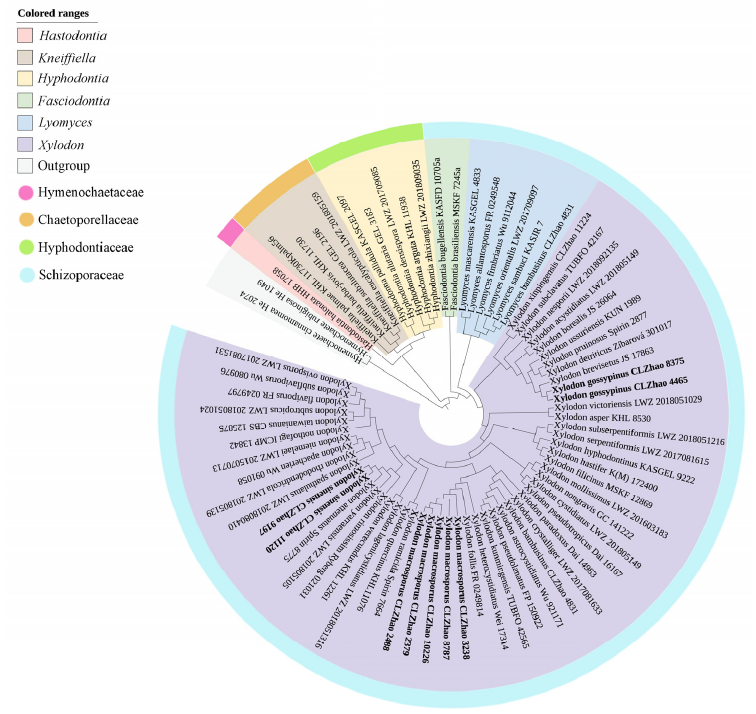
Figure 1. Maximum parsimony strict consensus tree illustrating the phylogeny of Xylodon and related genera in Hymenochaetales based on ITS+nLSU sequences. The families and genera represented by each color are indicated in the upper left of the phylogenetic tree.